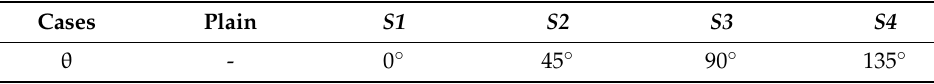
Table 4. Stationary test